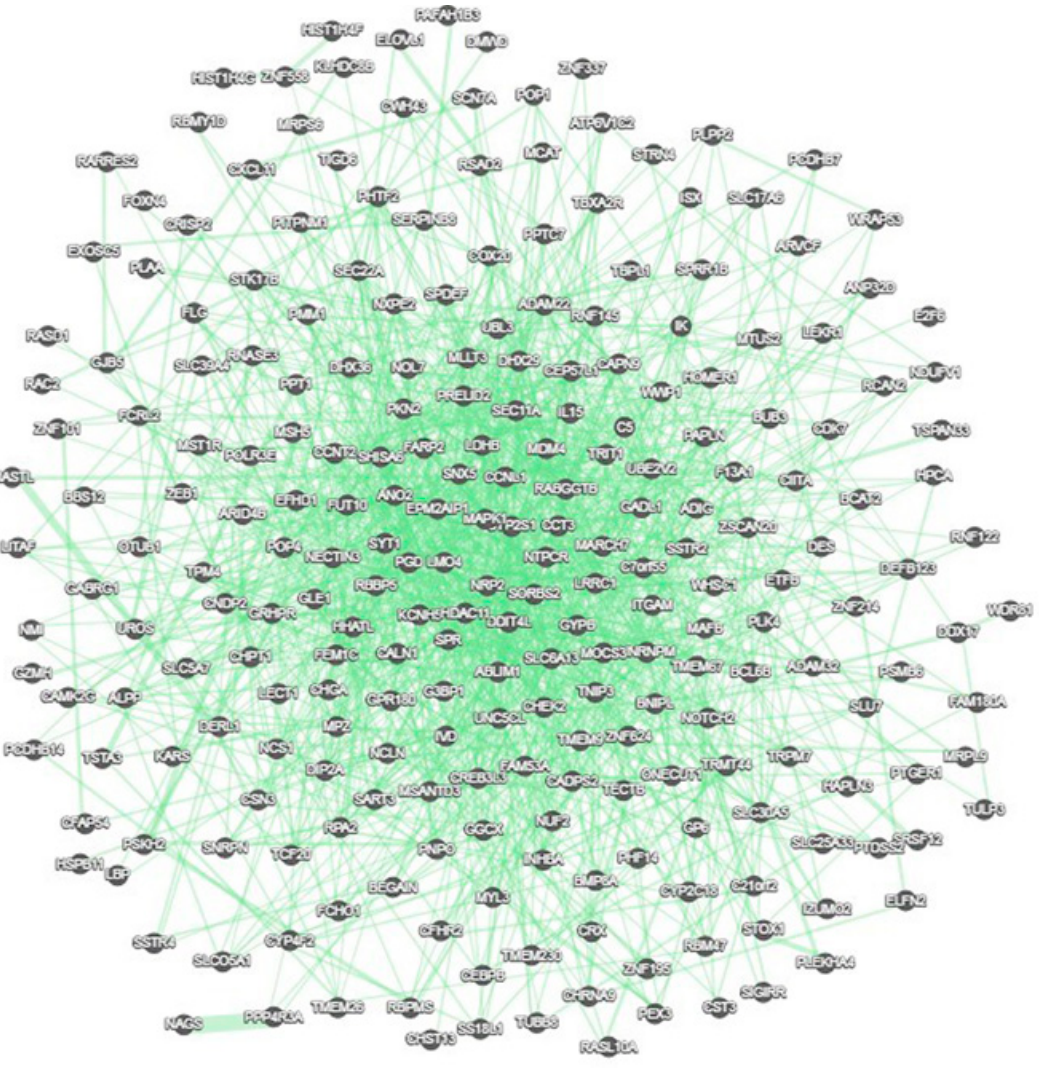
Figure A1. Network of genetic interactions derived from GeneMANIA analysis of random gene list 4, which was derived for comparison with the PGC gene dataset. No additional genes were included to form this network. Links between genes are indicated by green connecting lines. Although gene names are provided here, the purpose of this figure and the next is to provide an overall impression of the density of connections rather than to focus on interactions between individual genes.